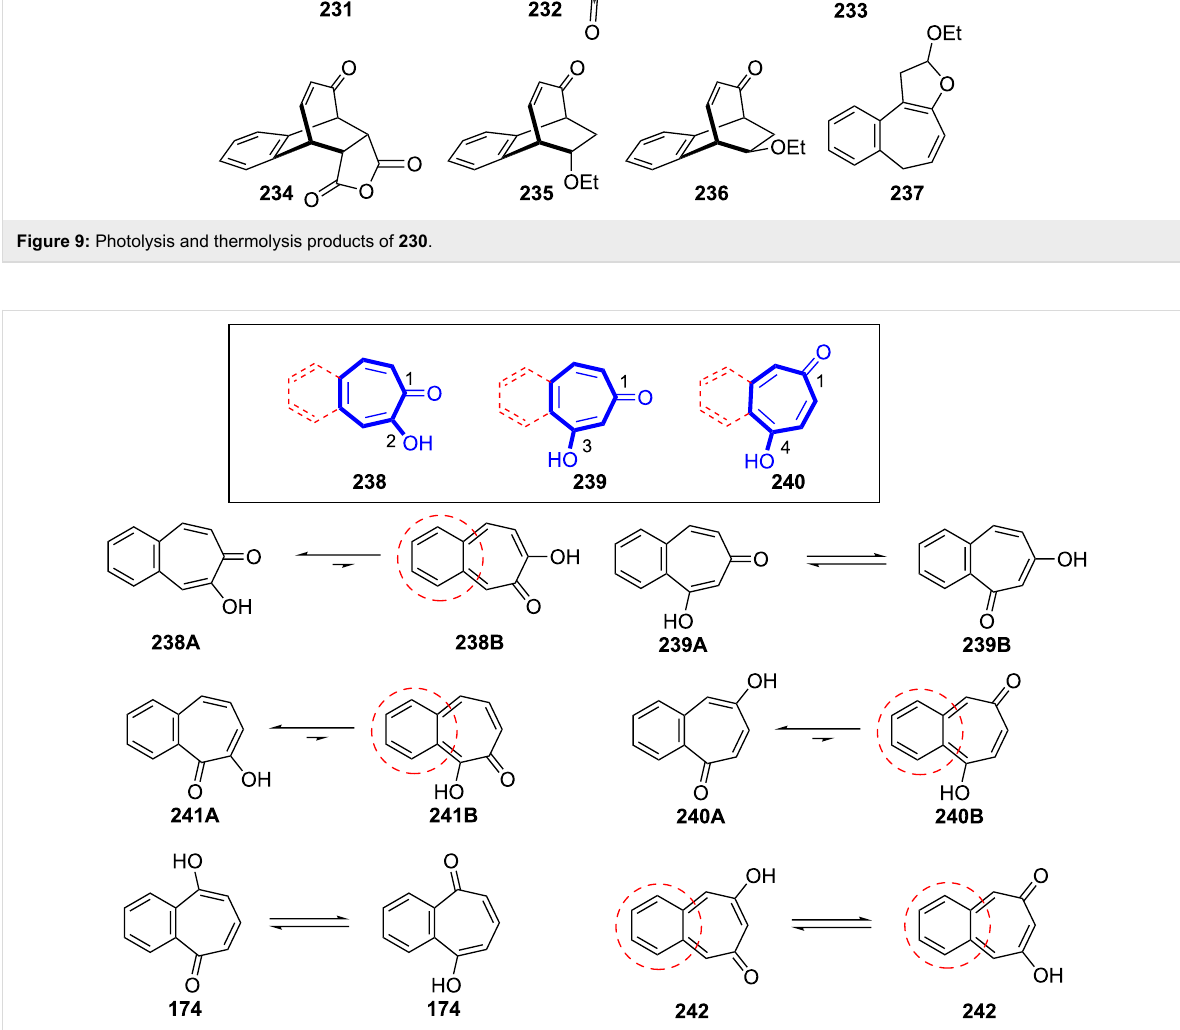
Figure 10: Benzotropolones and their tautomeric